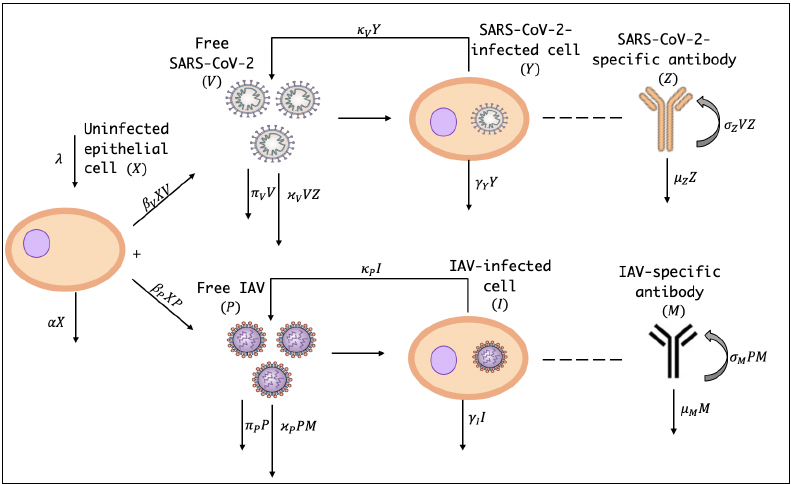
Figure 1. The schematic diagram of the IAV/SARS-CoV-2 coinfection dynamics